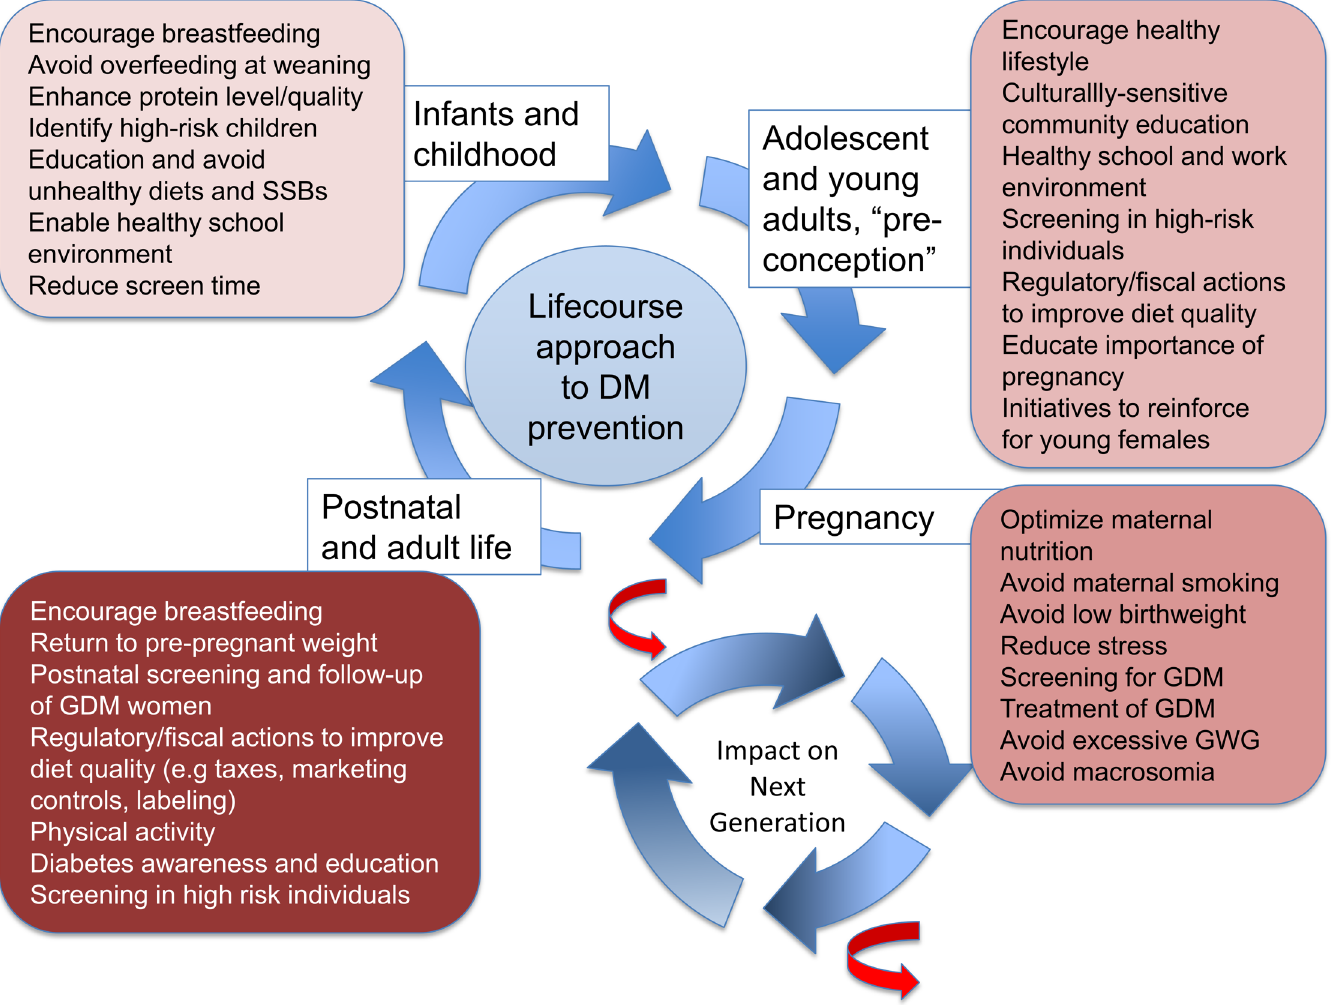
Fig 1. The intergenerational cycle of diabetes and obesity. Early life undernutrition, maternal diabetes, gestational diabetes,and maternal obesity are associated with increasedrisk of diabetes and obesity in the offspring, as well as youngerage of onset of diabetes.This risk can therefore be transmitted to subsequent generations. Some potentialinterventions targeting different stages of the reproductivecycle and life course are highlighted.